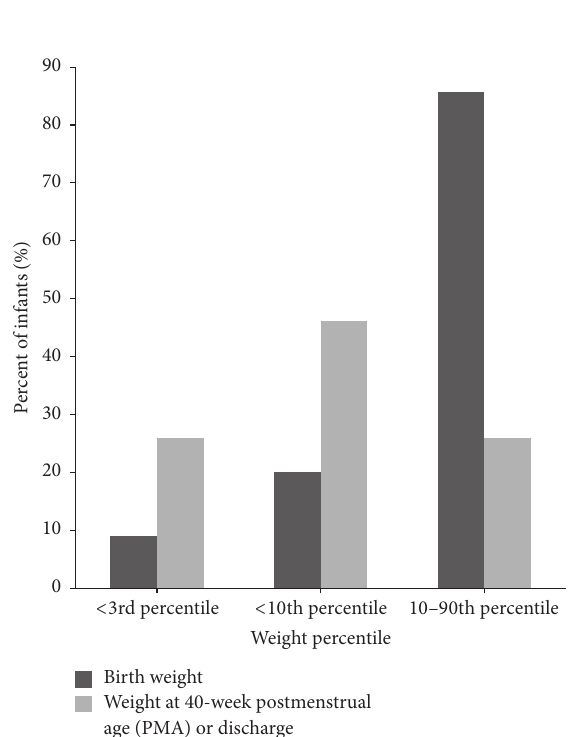
Figure 2: Weight percentile ranking from birth to 40-week post- menstrual age (PMA) or